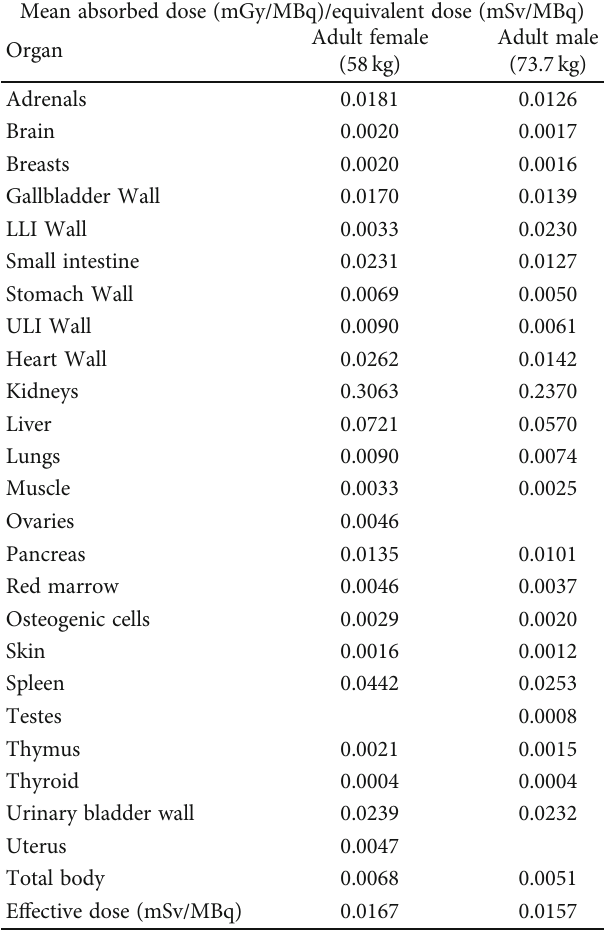
Table 3: Estimated radiation dose for [ 18 F]F-AraG in humans. Mean absorbed dose (mGy/MBq)/equivalent dose